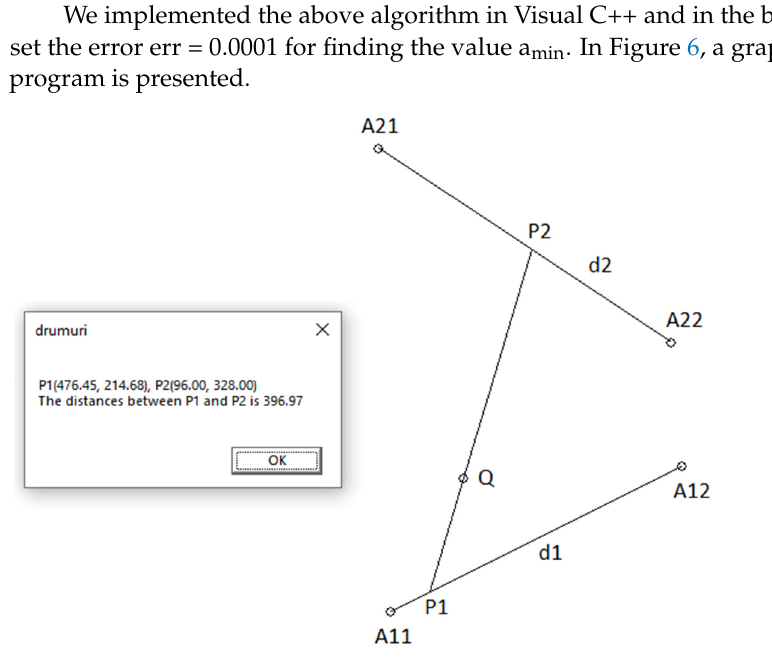
Figure 6. Output of the Visual C++ program.